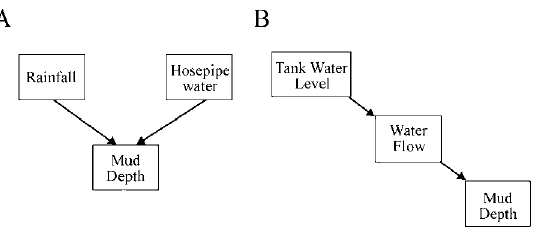
Figure 4. Interpreting Directed